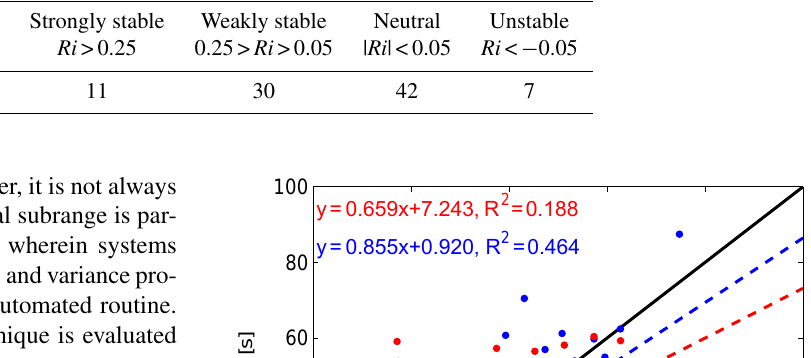
Table 2. Number of 30min time periods under various stability conditions, based on the Ri calculated for 100m.